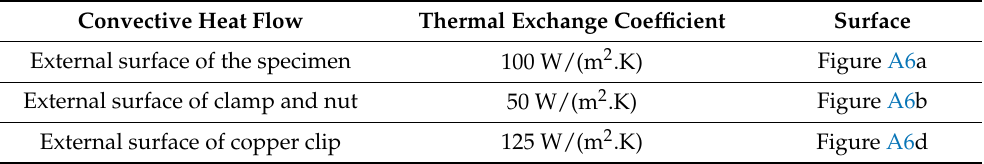
Table A2. Convective heat flow applied to the surfaces of different elements. Convective Heat Flow Thermal Exchange Coefficient Surface External surface of the specimen 100 W/(m 2 .K) Figure A6a External surface of clamp and nut 50 W/(m 2 .K) Figure A6b External surface of copper clip 125 W/(m 2 .K) Figure